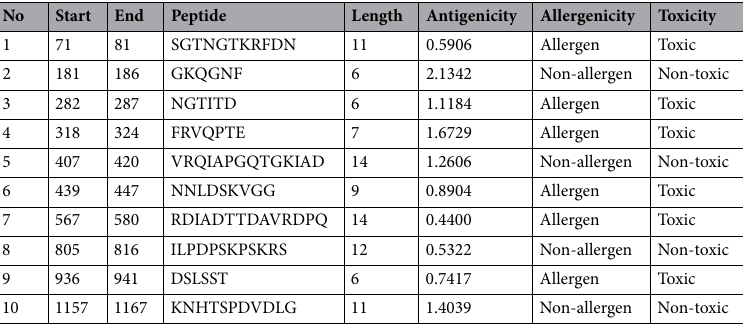
Table 1. BepiPred linear epitopes prediction using IEBD server 20 .